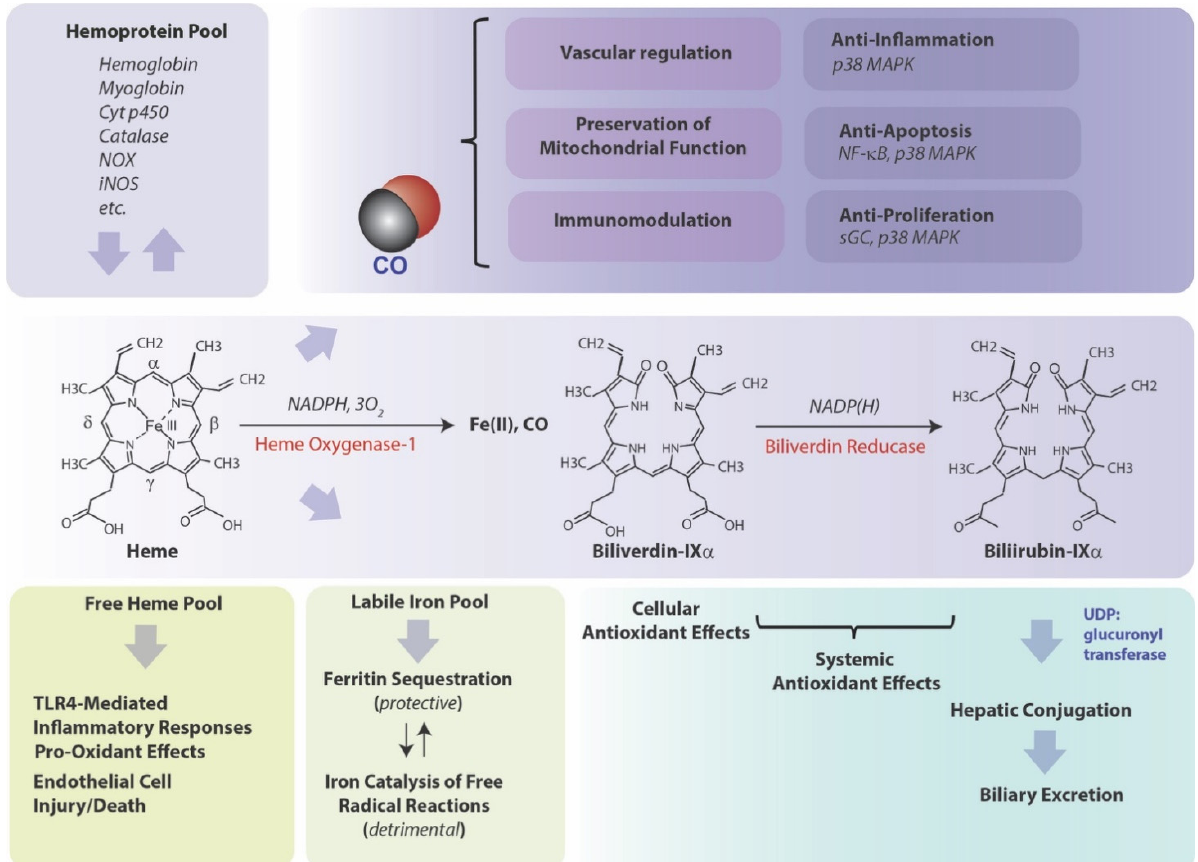
Figure 1. HO activity and role in cytoprotection. Heme oxygenase (HO: heme, hydrogen-donor:oxygen oxidoreductase ( α -methene-oxidizing, hydroxylating), EC: 1:14:99:3) is the rate-limiting step in heme degradation. HO catalyzes the oxidative cleavage of heme at the α -methene bridge carbon, released as carbon monoxide (CO), to generate biliverdin-IX α (BV), while releasing the central heme iron chelate as ferrous iron (Fe II). Enzymatic heme degradation requires three moles of molecular oxygen (O 2 ) and electrons derived from NADPH-cytochrome p450 reductase (EC: 1.6.2.4). The BV generated in the HO reaction is subsequently reduced by NAD(P)H: biliverdin reductase (BVR; EC: 1.3.1.24) to generate the lipid-soluble bile pigment bilirubin-IX α (BR). The source of heme for the HO reaction is derived from the turnover of hemoglobin and cellular hemoproteins. Free unbound heme released from hemolysis may represent a pro-oxidant hazard to vascular endothelium and may initiate pro-inflammatory reactions. BV and BR are known antioxidants, with circulating BR implicated as a mitigator of cardiovascular disease risk. Iron released from HO activity is equilibrated into ferritin storage, whereas unbound iron may propagate injury via catalysis of free radical-generating reactions. CO evolving from HO activity may modulate cellular function, via regulation of vascular function, immune system function, inflammation, apoptosis, and cellular proliferation. Abbreviations: CO: carbon monoxide; Cyt p450: cytochrome p450; iNOS: inducible nitric oxide synthase; NF- κ B: nuclear factor-kappa-B; NOX: NADPH oxidase isoforms; p38 MAPK: p38 mitogen-activated protein kinase; sGC: soluble guanylate cyclase; TLR4: Toll-like receptor-4; UDP: uridine 5’-diphosphate.